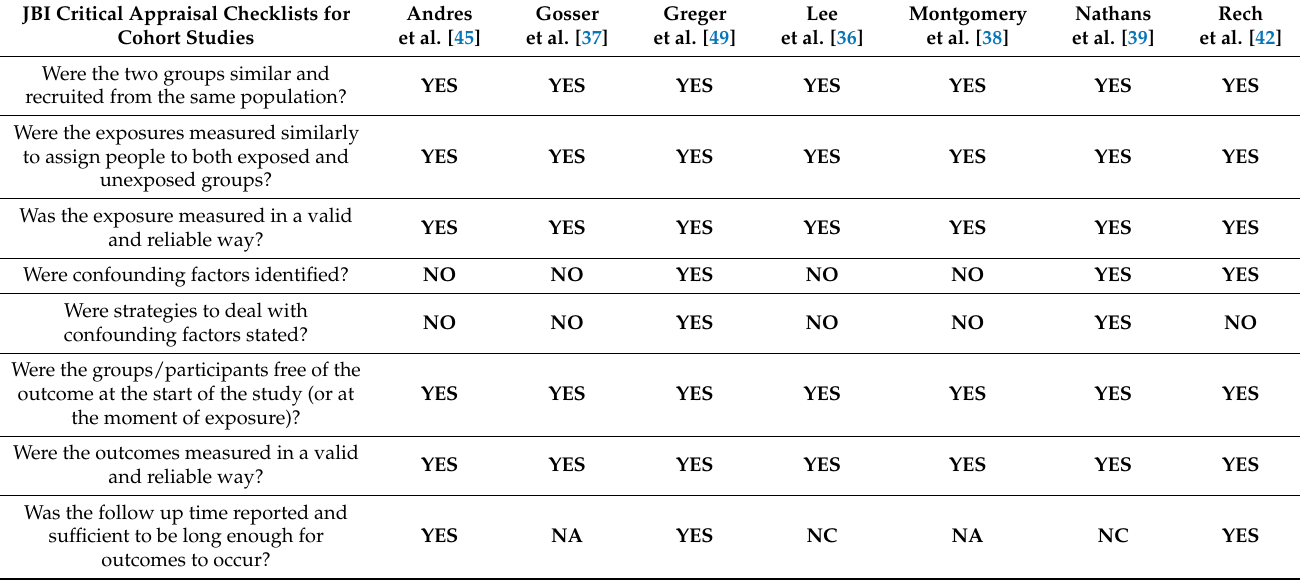
Table 4. Assessment of included cohort studies using Joanna Briggs Institute (JBI) critical appraisal tools (where NC indicates unclear, and NA indicates not